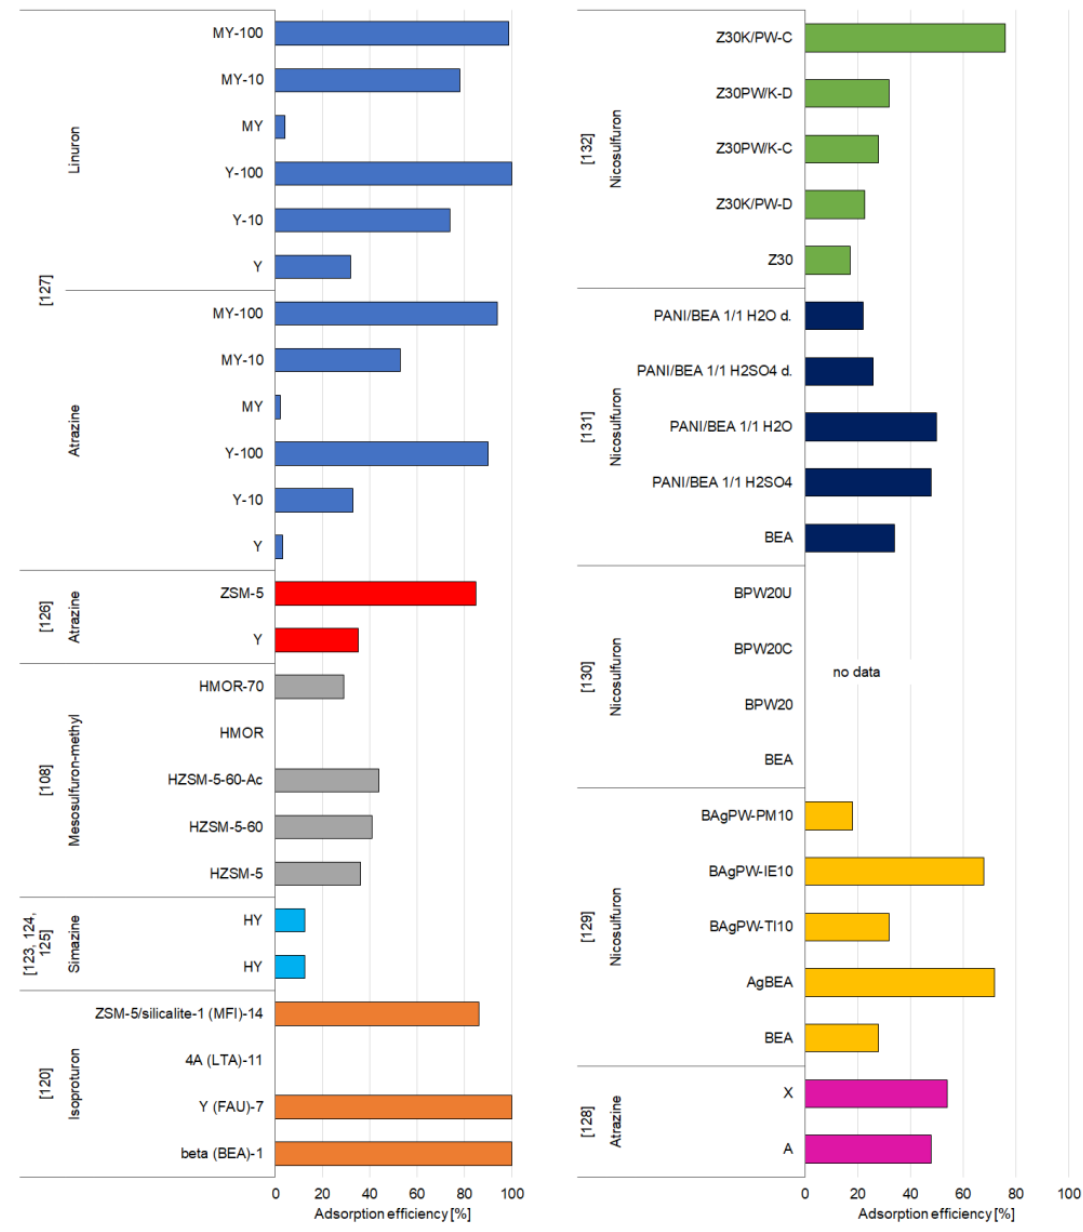
Figure 7. Effectiveness of removal of triazine and urea pesticides by synthetic zeolites. Glyphosate-Based